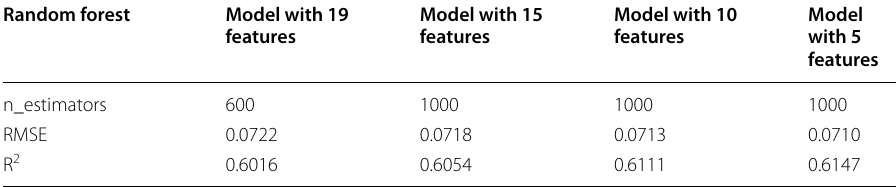
Table 9 Performance metrics with RF Random